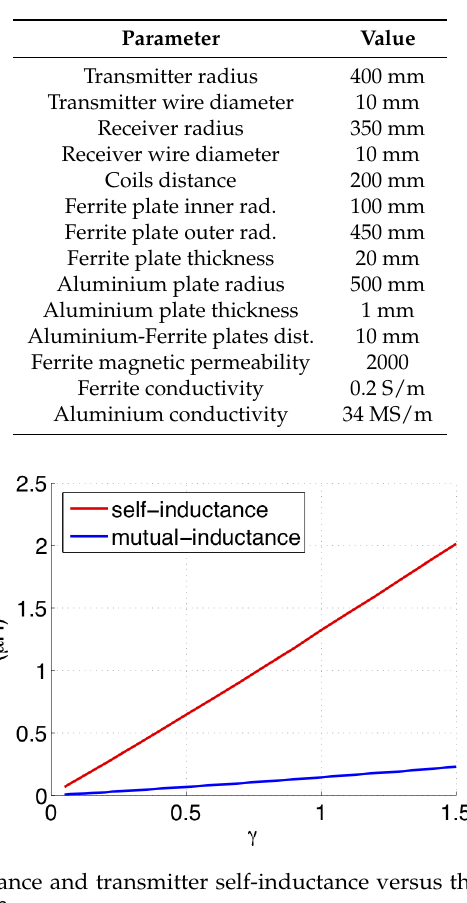
Table A1. Simulated IPT system parameters.